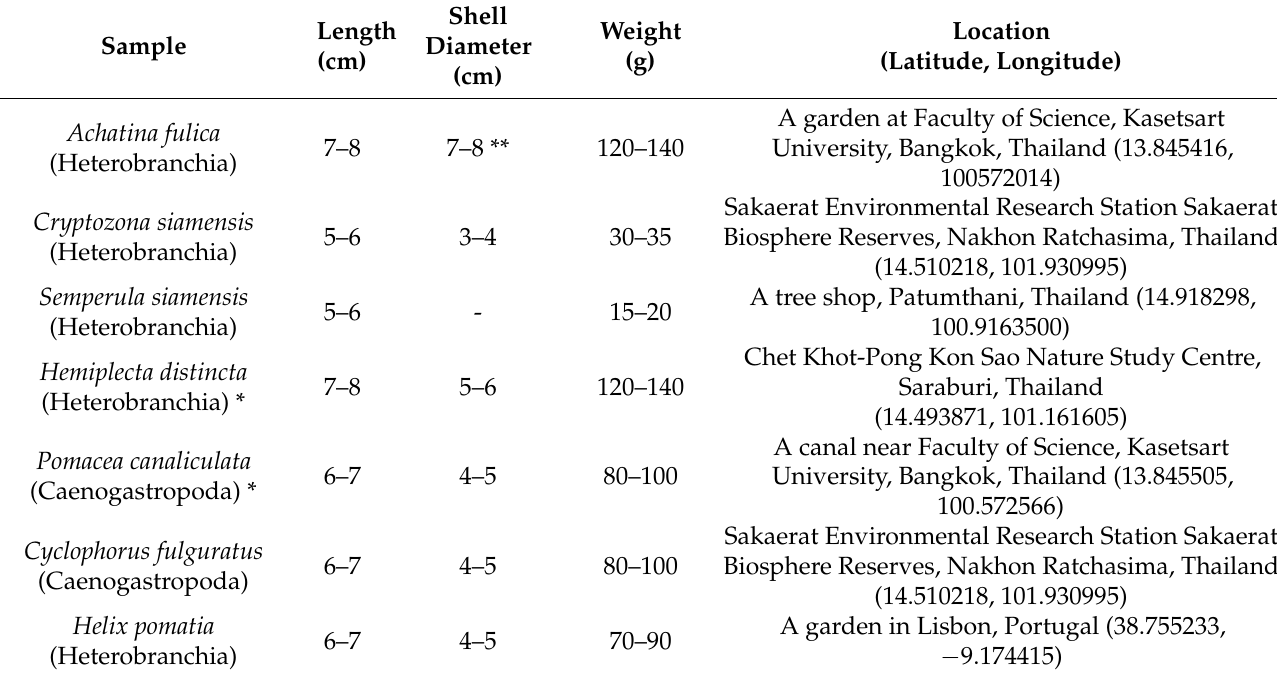
Table 1. List of gastropod samples used in this